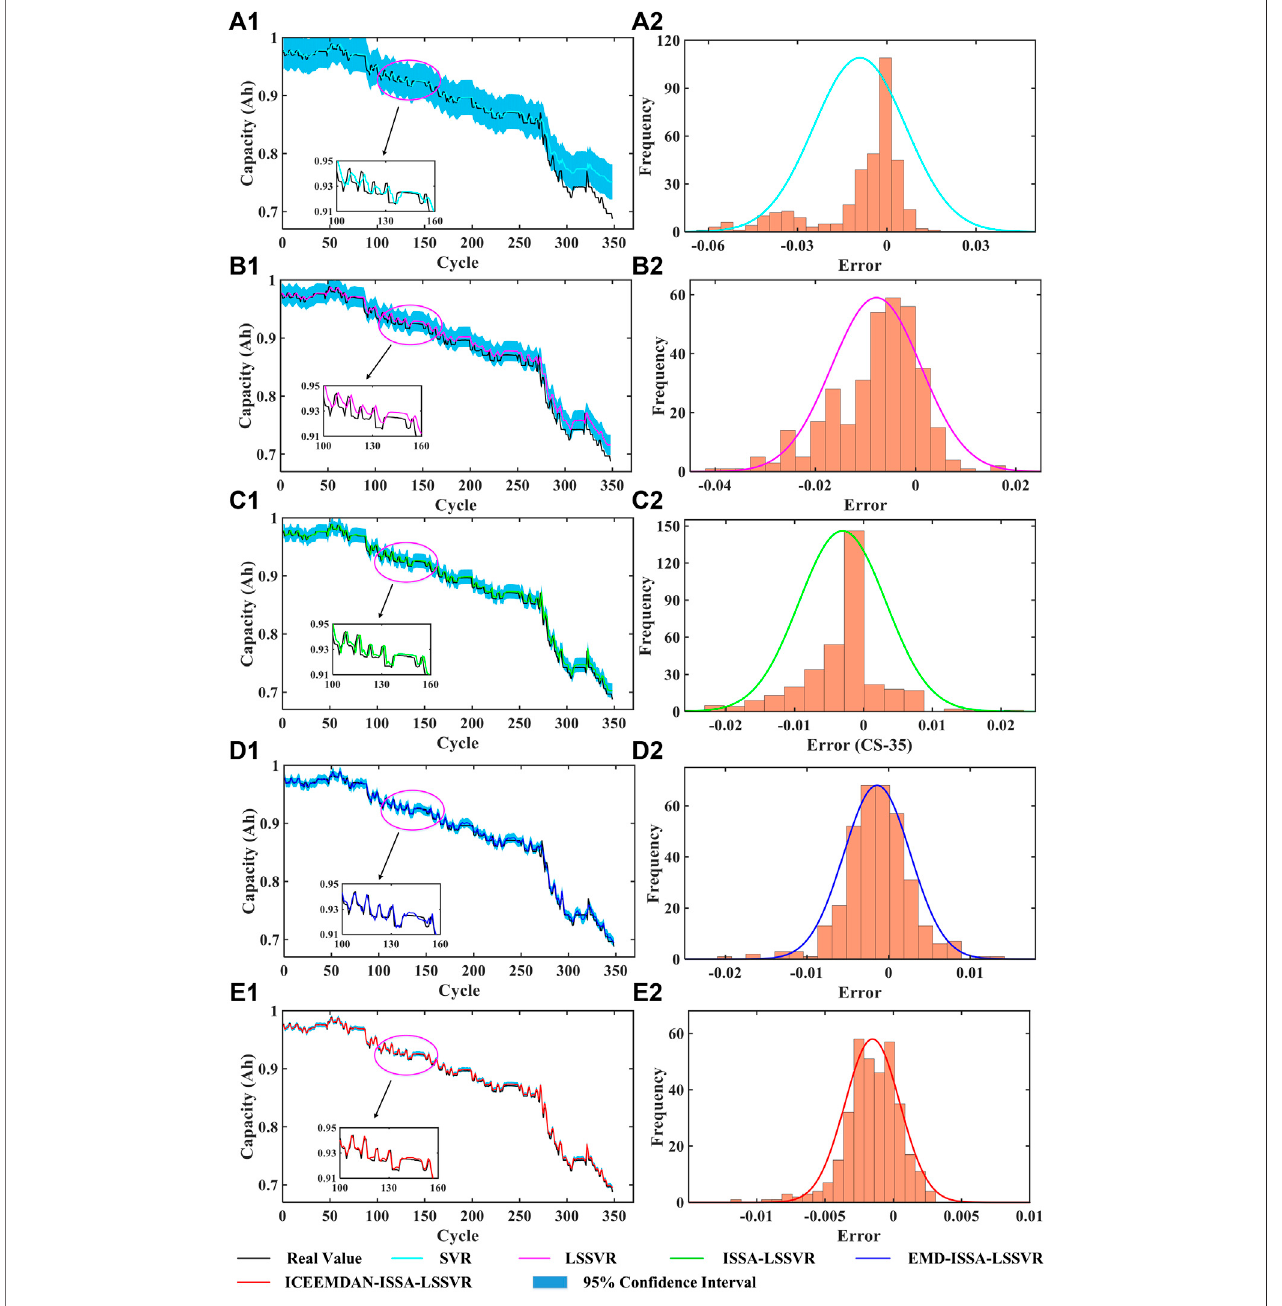
FIGURE 6 | Prediction results of the fi ve algorithms on the CS-35 battery. (a1 – e1) Prediction capacity. (a2 – e2) Probability density curve of the prediction error.